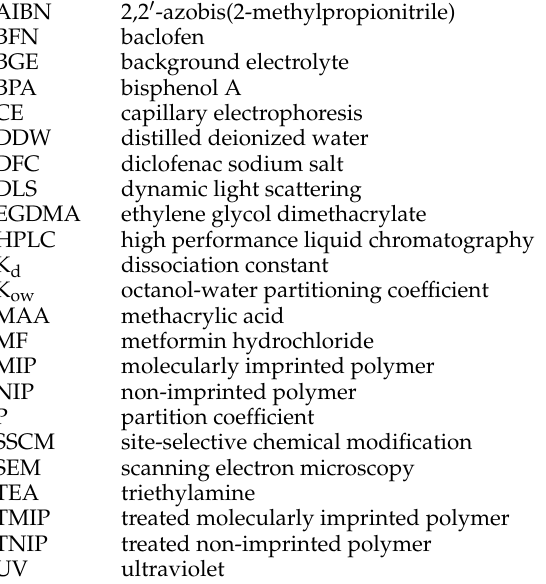
Table S1: Preparation of MIPs using different molar ratios of BPA to MAA while keeping EGDMA constant, Table S2: Percent binding results for BPA, DFC and MF (individually or in mixture) and electrophoretic mobility for NIPs, Table S3: Percent binding results for BPA, DFC and MF (individually or in mixture) and electrophoretic mobility for various TNIPs, Table S4: Percent binding results for BFN (individually) with various MIPs, NIPs, TMIPs and TNIPs, Table S5: HPLC-UV peak heights, peak areas and retention times for BFN, BPA, DFC and MF. Acknowledgments: Noof A. Alenazi would like to express her sincere gratitude to the Saudi Cultural Bureau